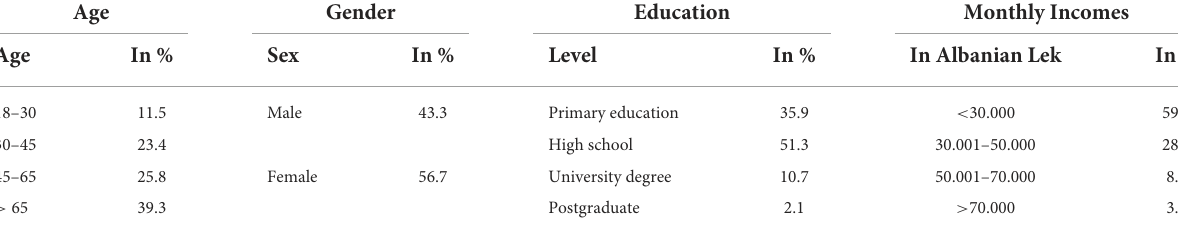
TABLE 1 Sociodemographic